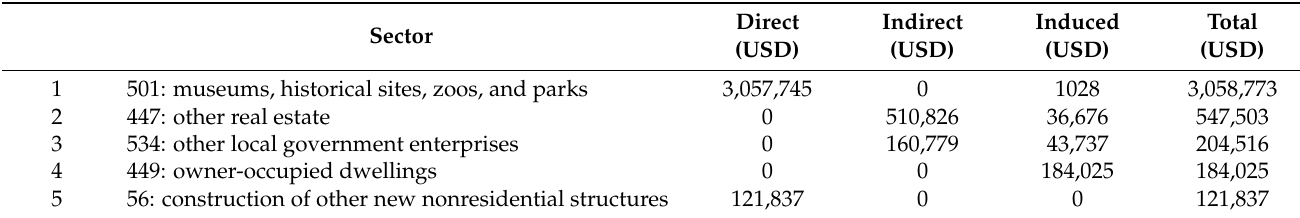
Table A19. Top Five Affected Sectors by Revenue.